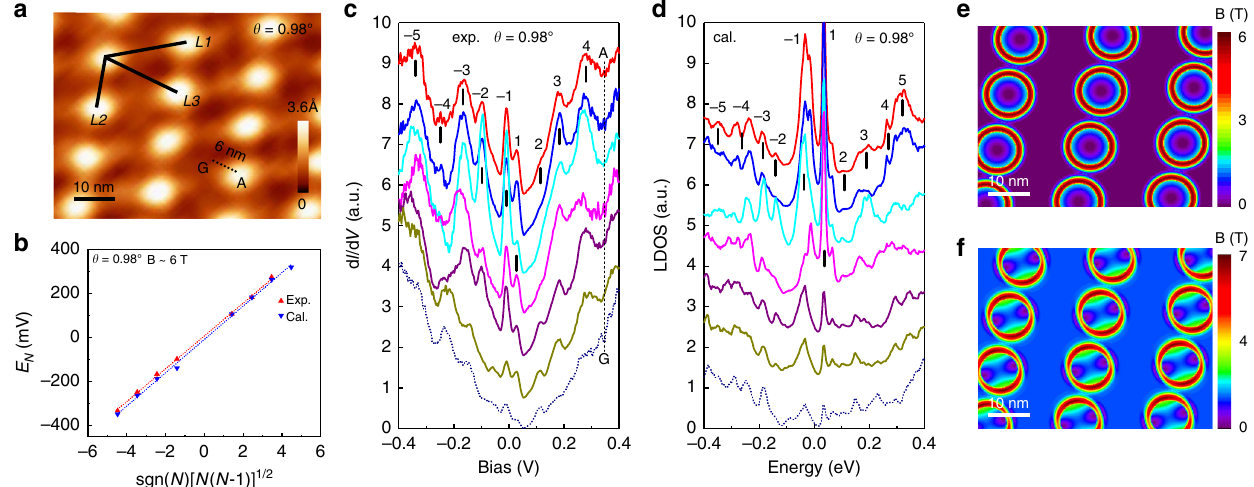
Fig. 4 Electronic properties and PMF behaviors of TBG with uniaxial heterostrain. a STM topography image (65 nm ´ 50 nm ) with distorted moiré pattern. Twist angle θ ¼ 0 : 98 (cid:1) with heterostrain σ ¼ 0 : 78 % . Sample bias V ¼ 200 mV , tunneling current I t ¼ 1 : 0 nA . The three moiré wavelengths are: L 1 ¼ 20 : 3 nm , L 2 ¼ 12 : 3 nm , and L 3 ¼ 19 : 2 nm . b Linear fi ttings of the peak energies and Landau index obtained from both the measured and calculated datas. The estimated PMF value is about 6 T. c dI/dV spectra with interval of 1 nm taken from AA to AB region indicated by black dots in a . The curves have been vertically shifted for clarity. d Local density of states computed from the same locations in a . The obtained features are in good agreement with our experimental results. e , f Calculations of the magnitude of the pseudo-manetic fi elds B produced by the atomic distortion of the top layer (unstrained one, e ) and the bottom layer (strained one, f ),